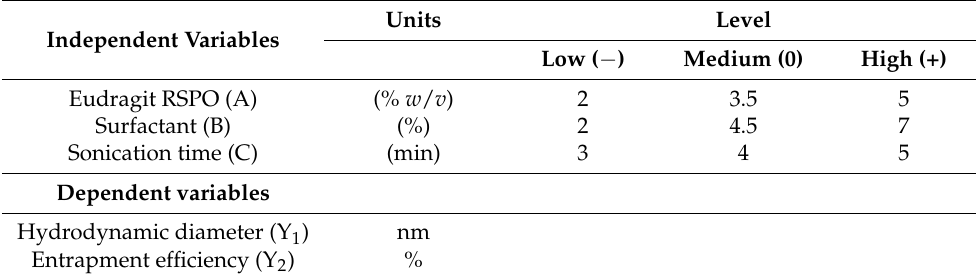
Table 1. Independent and dependent variables used to prepare ALG-NPs.